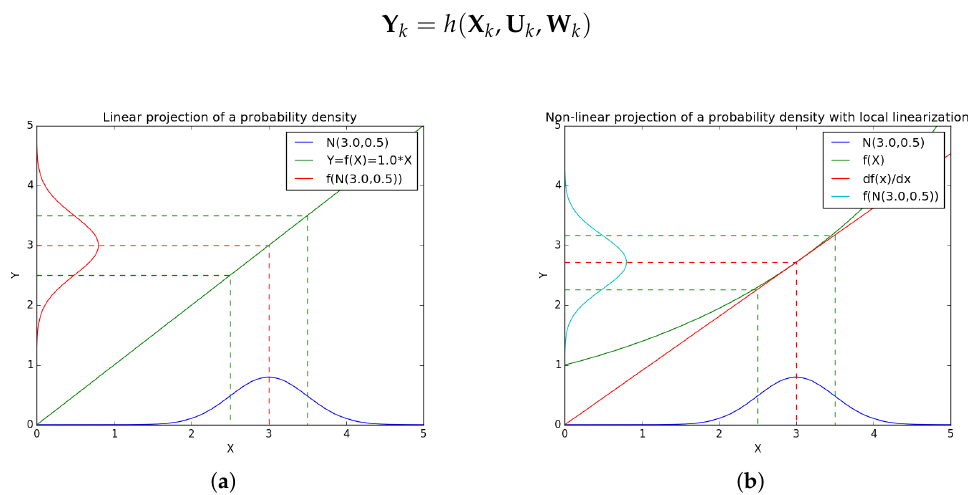
Figure 2. Linear projection methods for: ( a ) linear system (Kalman projection); and ( b ) non-linear system local linearization (EKF